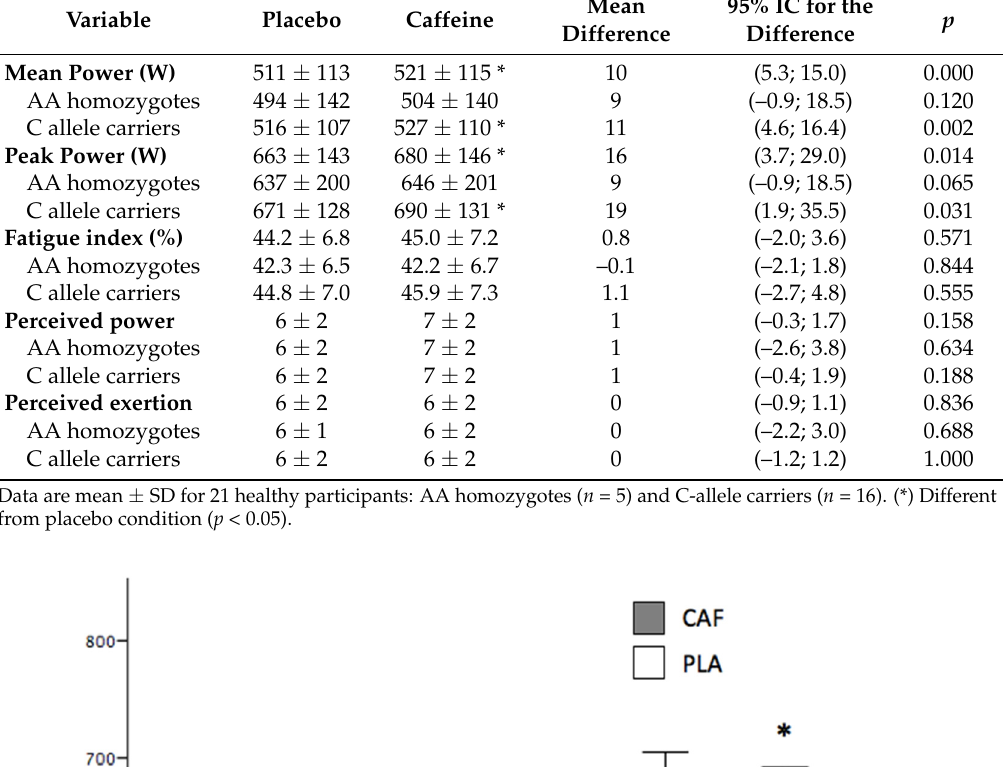
Figure 3. Individual responses during the Wingate test. Performance change from placebo condition to caffeine condition for AA homozygotes ( n = 5) and C ‐ allele carriers ( n = 16). Table 3 depicts the prevalence of side effects after the ingestion of caffeine or a placebo. There were no significant differences in the prevalence of side effects after the ingestion of caffeine and the ingestion of the placebo (Table 3; p > 0.05). Although the differences between AA homozygotes and C ‐ allele carriers did not reach statistical significance in any of the side effects analyzed, 31.3% of C ‐ allele carriers reported increased nervousness, while none of the AA homozygotes perceived this side effect.